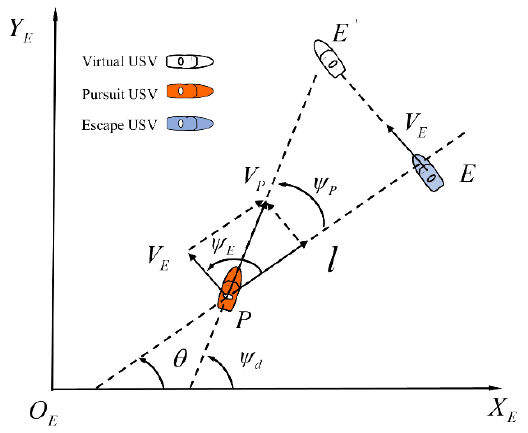
Figure 1. Schematic diagram of guidance method.